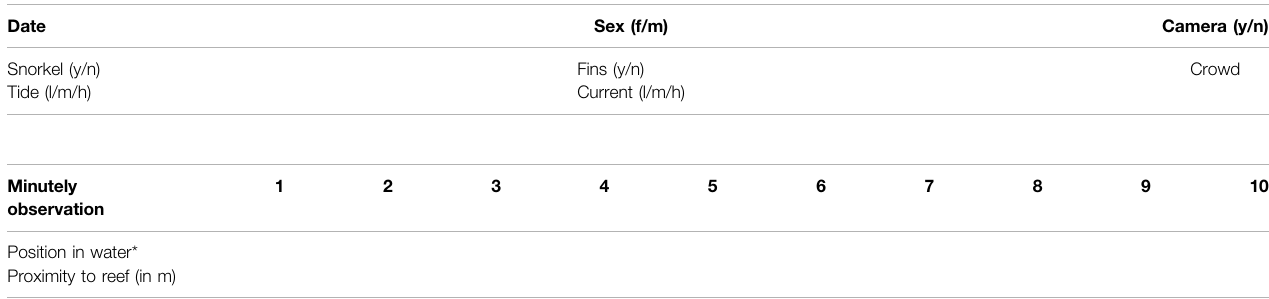
Observation Scheme for Experiment